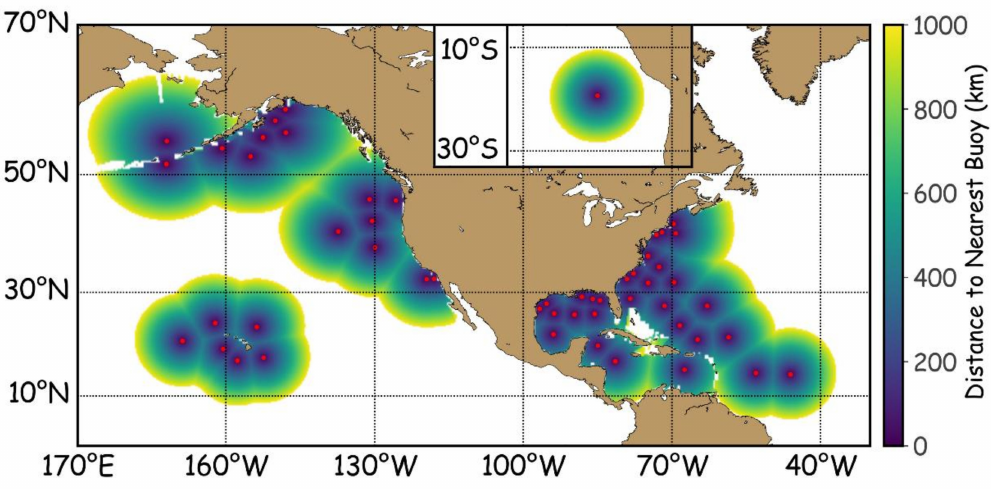
Figure 1. The locations of the 51 National Data Buoy Center (NDBC) buoys (red dots) used in the study. The inner subplot shows the location of buoy 32012. A few buoys could be redeployed during the study period. The color indicates the distance of an oceanic point to its nearest buoy. Distances exceeding 1000 km are not shown, and distances are also not shown if the great circle connecting two points is blocked by